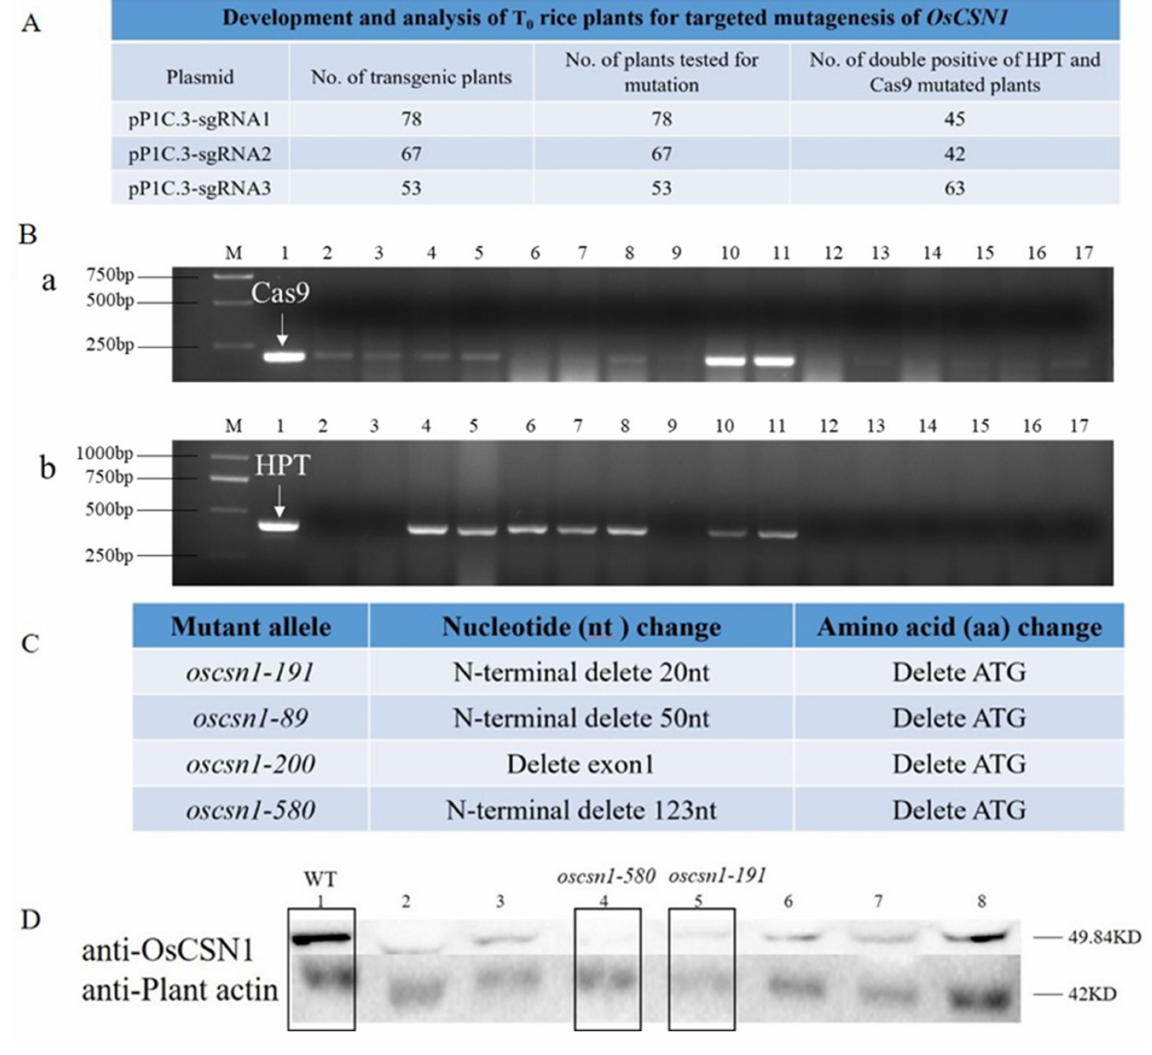
Figure 2. CRISPR/Cas9-induced mutations in OsCSN1. ( A )Development and analysis of T 0 rice plants for targeted mutagenesis of OsCSN1. ( B ) The upstream and downstream primers were designed using the hygromycin phosphotransferase gene (HPT) and Cas9 gene as templates, and the extracted template DNA of oscsn1 mutants was double screened to identify positive plants containing knockout plasmids. Identification of transgenic plants by PCR. M, DL-2000marker; 1, pP1C.3 plasmid (PCR-positive control), 4, 5, 8, 10, and 11, double PCR-positive transgenic plants. ( a ) The gene of Cas9 . ( b ) The gene of HPT . ( C ) Nucleotide mutations and the corresponding changes in amino acid sequences are summarized. ( D ) Detection of OsCSN1 in oscsn1 mutants and wild type by western blot. Actin was probed and served as a loading control. 1, wild type; 2–8, oscsn1